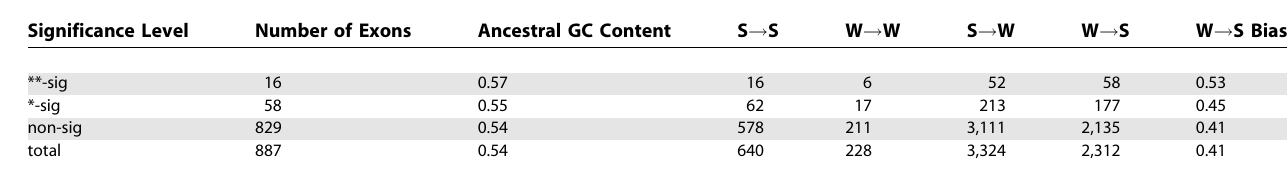
Table 4. Patterns of Nucleotide Substitution in Exons with Evidence for Elevated d N /d S on the Human Lineage Significance Level